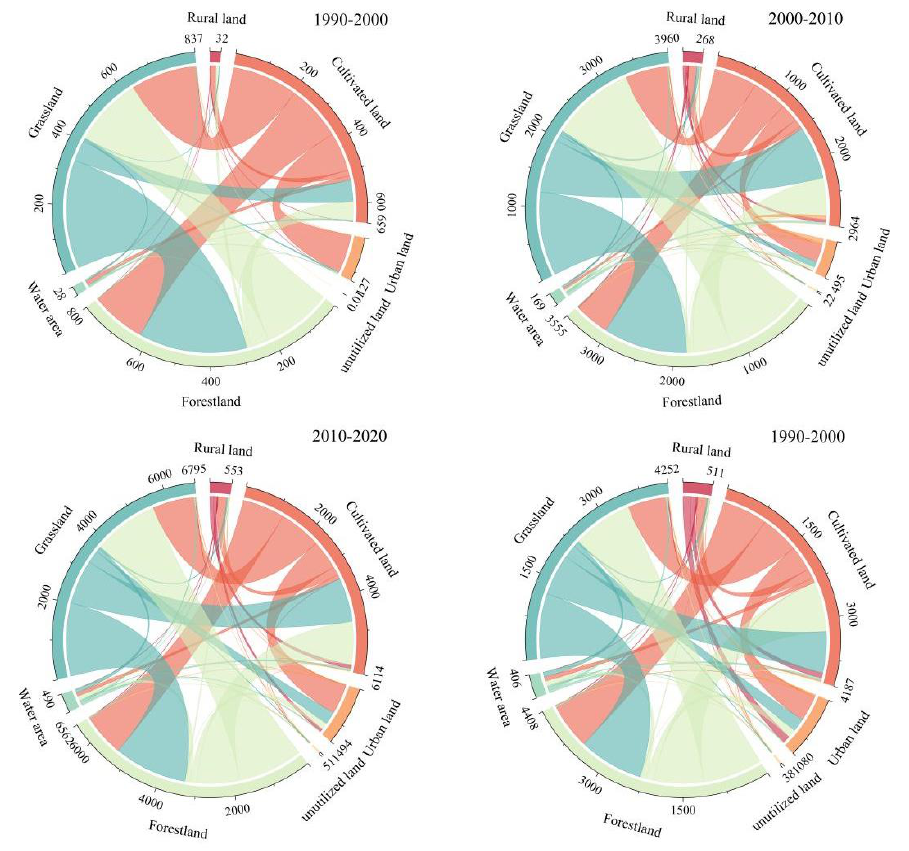
Figure 3. Land use change chord map of central Yunnan urban agglomeration, 1990 – 2020.